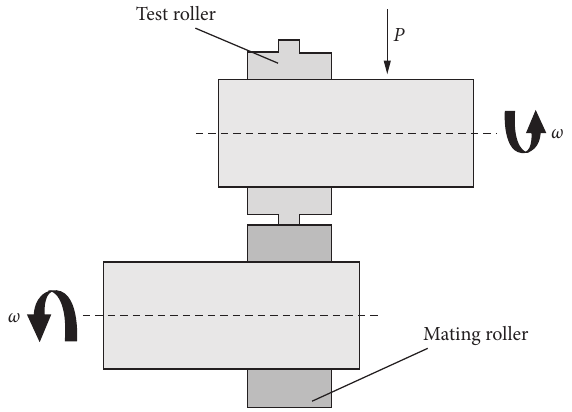
Figure 1: Principle of linear contact rolling contact fatigue